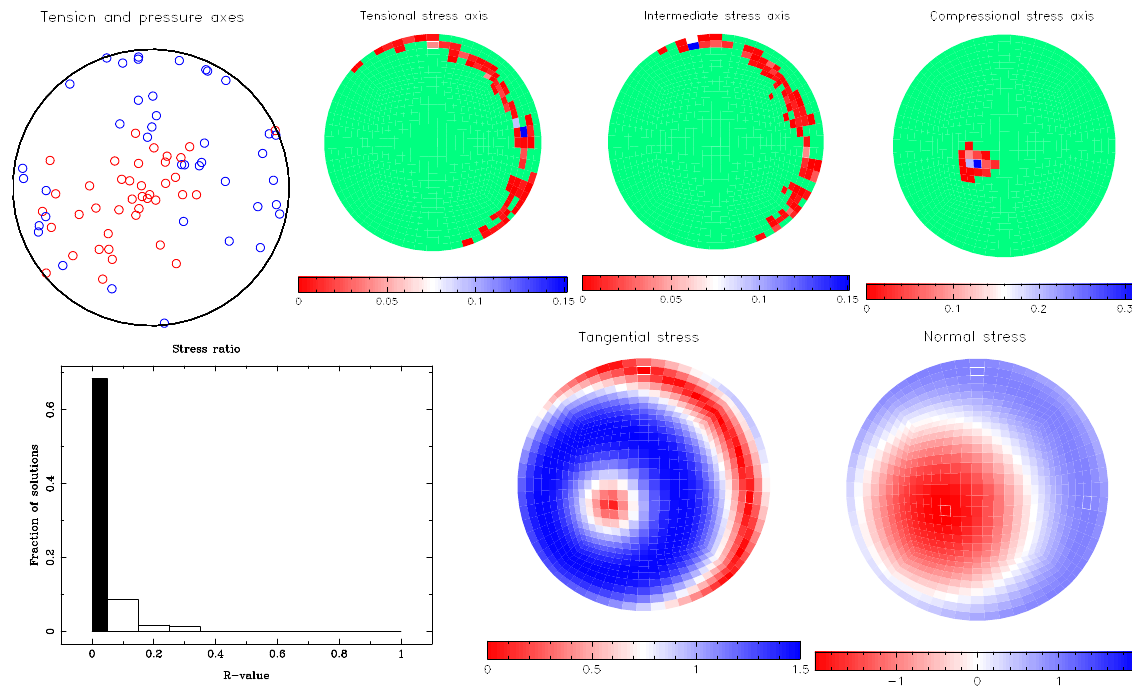
Fig. 6. Results of stress inversion for cluster of shallow earthquakes near Columbo volcano . Explanation of subfigures in figure 5.